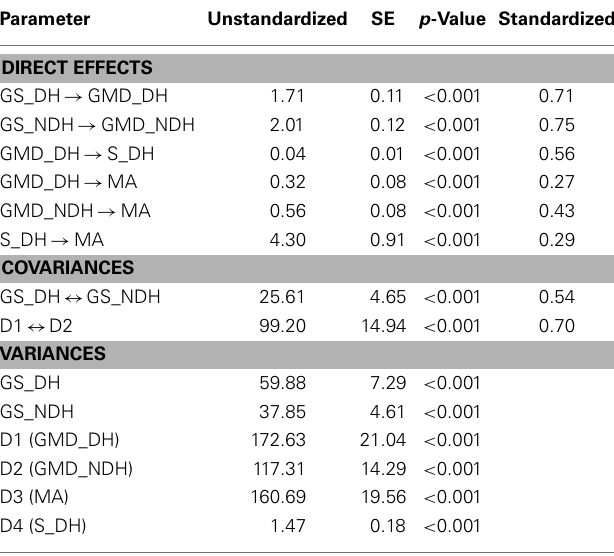
Table 4 | Maximum likelihood parameter estimates for the final path model of hand functioning in children with CP .